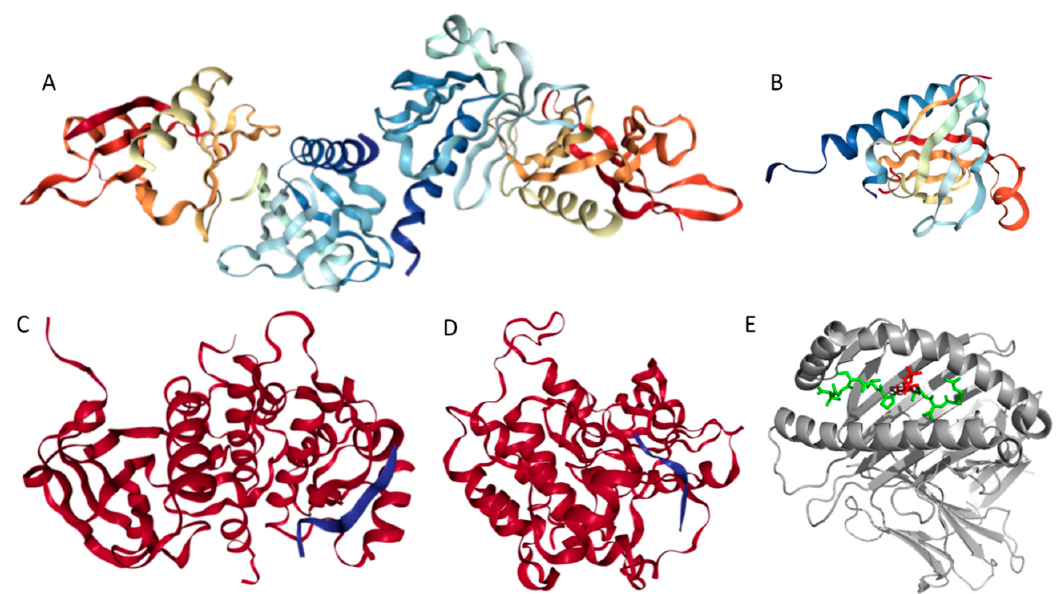
Figure 6. Structural information available for the members of human IRS family. ( A ) Crystal structure of the dimeric form of the PH-PTB targeting region of human IRS1 (residues 4–267, PDB ID: 1QQG). ( B ) NMR structure of the PTB domain of IRS1 (residues 157–267) complexed with a tyrosine-phosphorylated peptide derived from the IL-4 receptor (PDB ID: 1IRS). ( C ) Crystal structure of the GRB2-binding region of human IRS1 (residues 891–902, blue ribbon) complexed with the protein kinase domain of the insulin-like growth factor 1 receptor (red cartoon) (PDB ID: 1K3A). ( D ) Crystal structure of a short peptide of human IRS1 (residues 731–736, blue ribbon) complexed with the insulin receptor (red cartoon) (PDB ID: 2Z8C). ( E ) The IRS2 peptide (residues 1097–1105, RVASPTSGV, green structure) complexed with the A-2 α chain of human leukocyte antigen (HLA) class I histocompatibility antigen, HLA A2 (PDB ID: 3FQW).